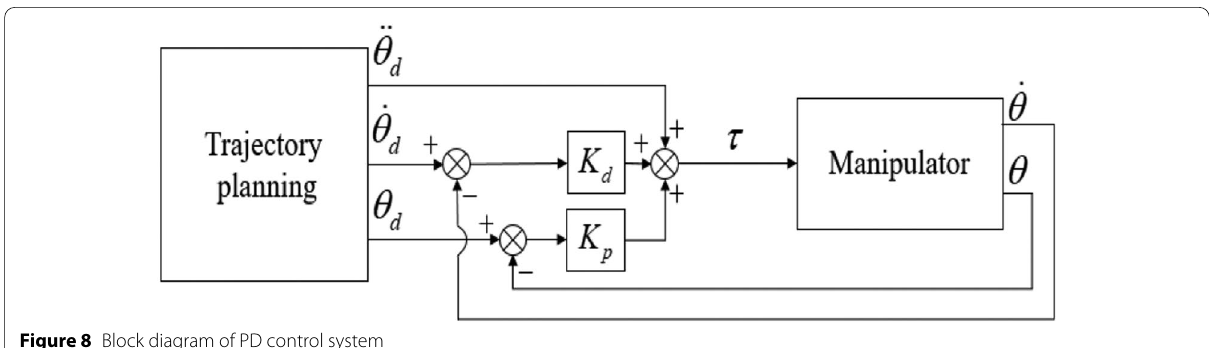
Figure 8 Block diagram of PD control system